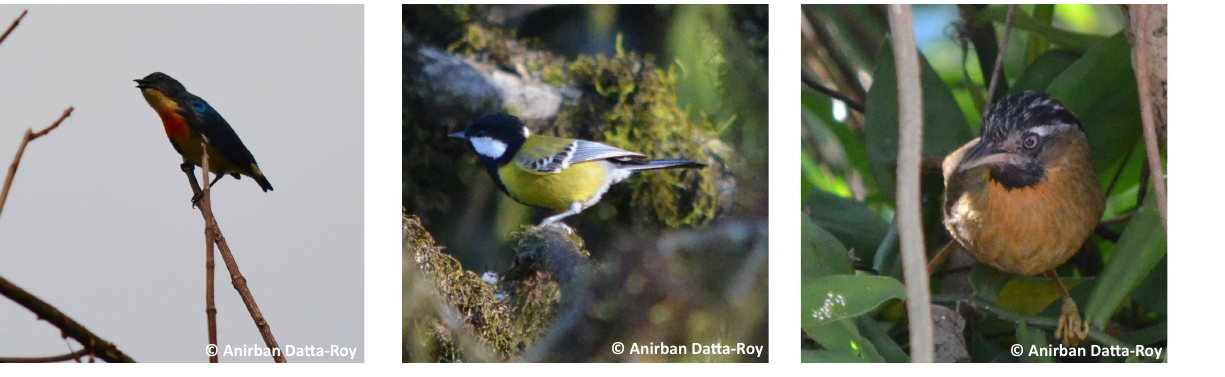
Image 2. Fire-breasted Flowerpecker Image 3. Green-backed Tit Image 4. Grey-throated Babbler